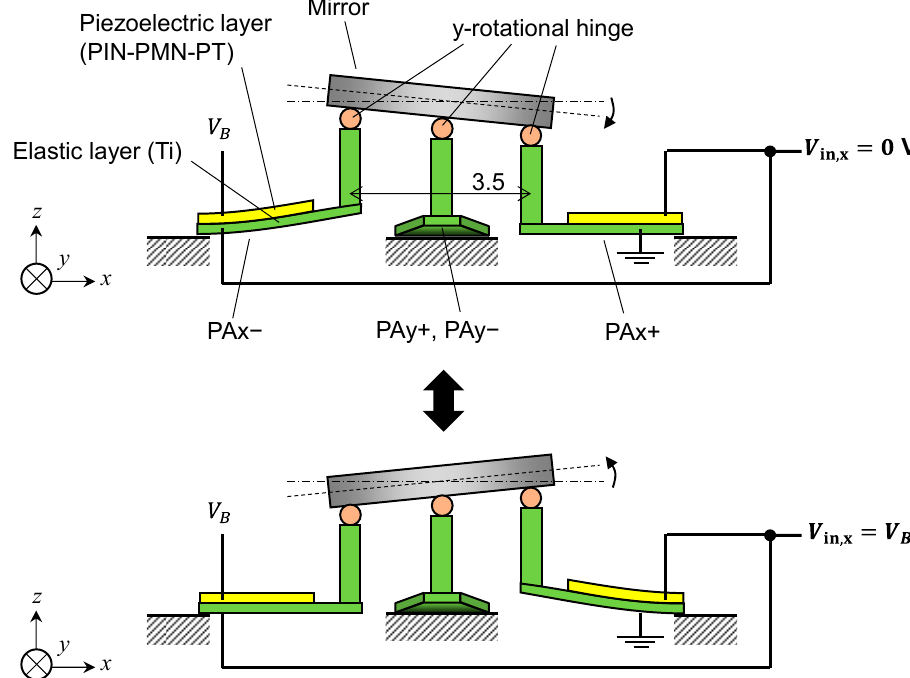
Figure 2. Principle of the scanning operation.